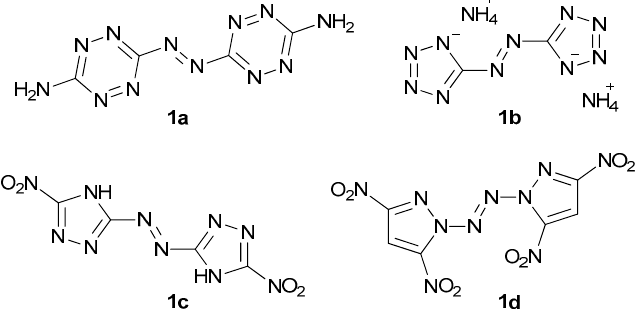
Figure 1. Some of the energetic azo compounds: 3,3 ′ -azobis(6-amino-1,2,4,5-tetrazine) ( 1a ), diammonium 5,5 ′ -azobis(tetrazolate) ( 1b ), 5,5 ′ -dinitro-3,3 ′ -azobis(1 H -1,2,4-triazole) ( 1c ), and 1,1’- azobis(3,5-dinitropyrazole) ( 1d ).